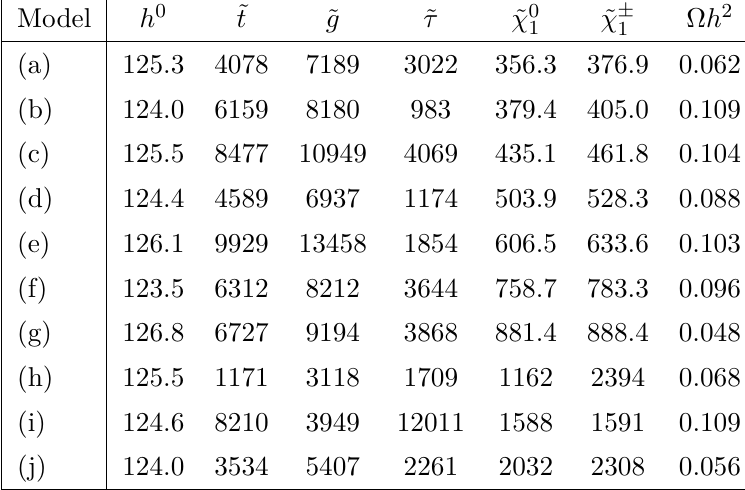
Table 7 . Low scale SUSY mass spectrum showing the Higgs boson, the stop, the gluino, the stau and the light electroweakino masses and the LSP relic density for the benchmarks of table 6.